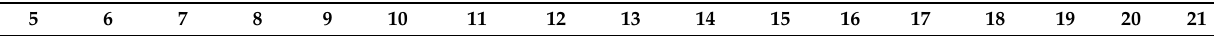
Table A6. Results of ecosystem services pairwise